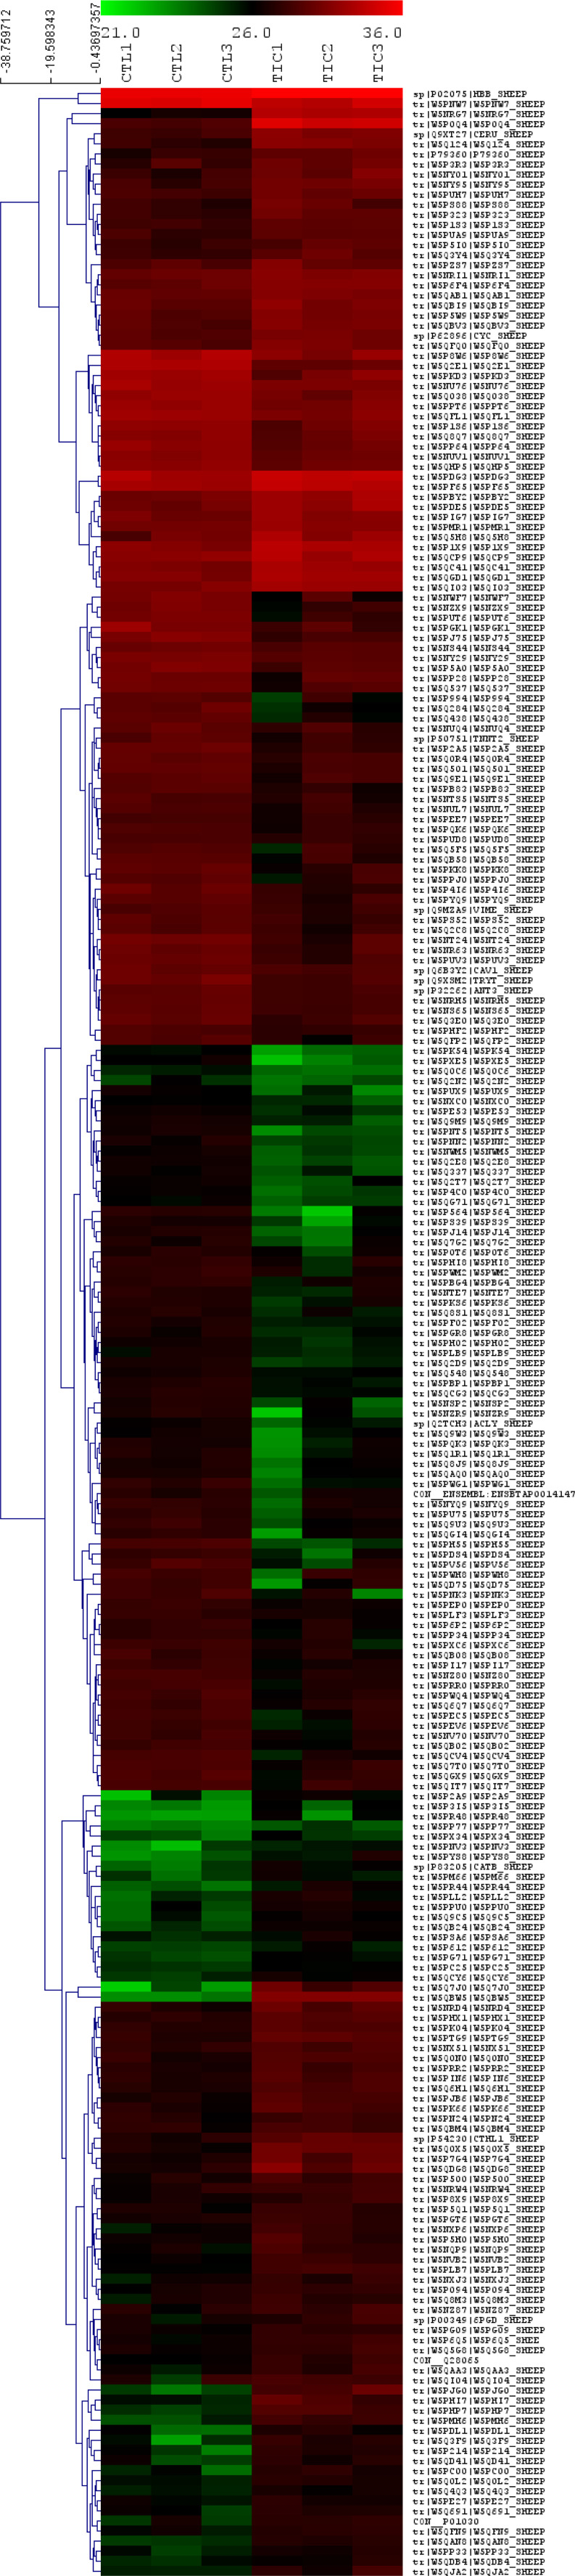
Proteomics revealed 247 differentially expressed proteins in tachycardia-induced cardiomyopathy (TIC) tricuspid anterior leaflets.Heat map showing expression of significant (p<0.05, fold change >2) differentially expressed proteins between control (CTL, left three columns, n = 3) and TIC (right three columns, n = 3) groups. Each column represents a biological replicate within each group. Each row represents a protein, as marked by their uniport identifiers. Red, black and green correspond to high, medium and low intensity values, respectively. Proteins are clustered according to similarities in expression patterns and total intensities.